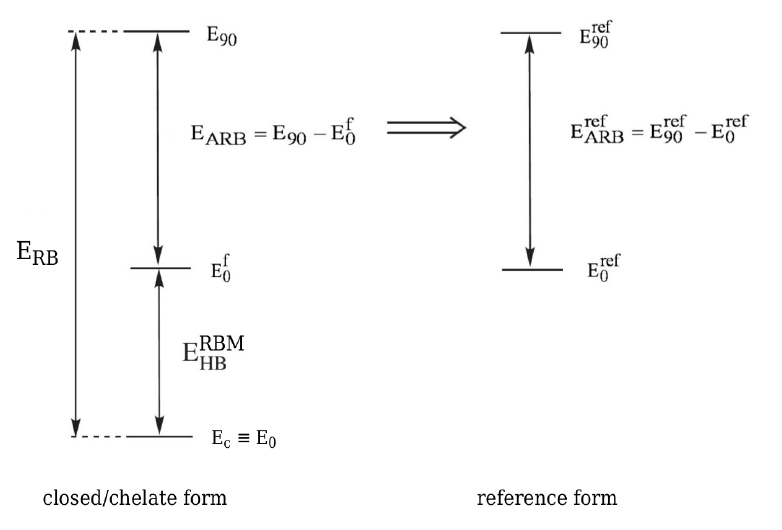
Figure 15. Scheme showing the way of estimating the energy of an intramolecular hydrogen bond according to RBM.